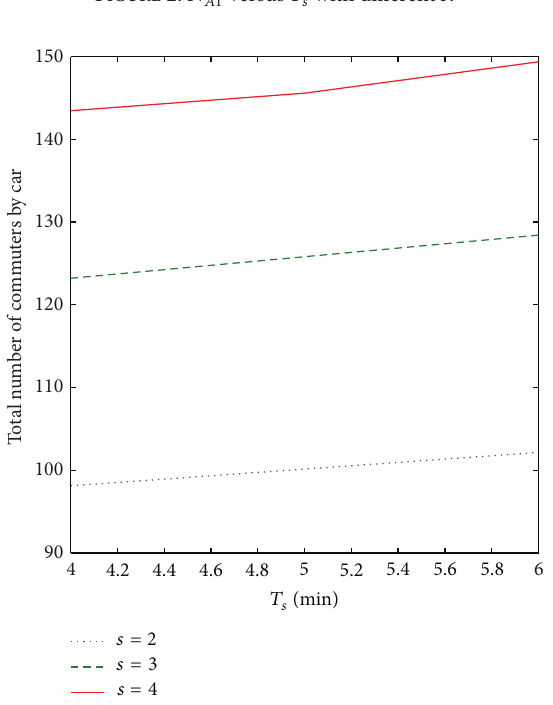
Figure 2: 𝑁 𝐴1 versus 𝑇 𝑠 with different 𝑠 .